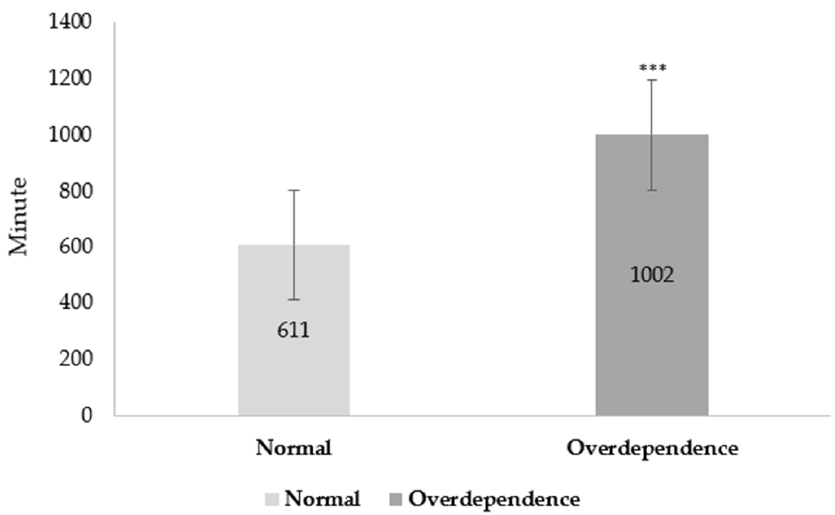
Figure 1. Mean of smartphone usage time (minute per week). The significant differences between the two groups. *** p < 0.001, Error bars represent the 95% confidence